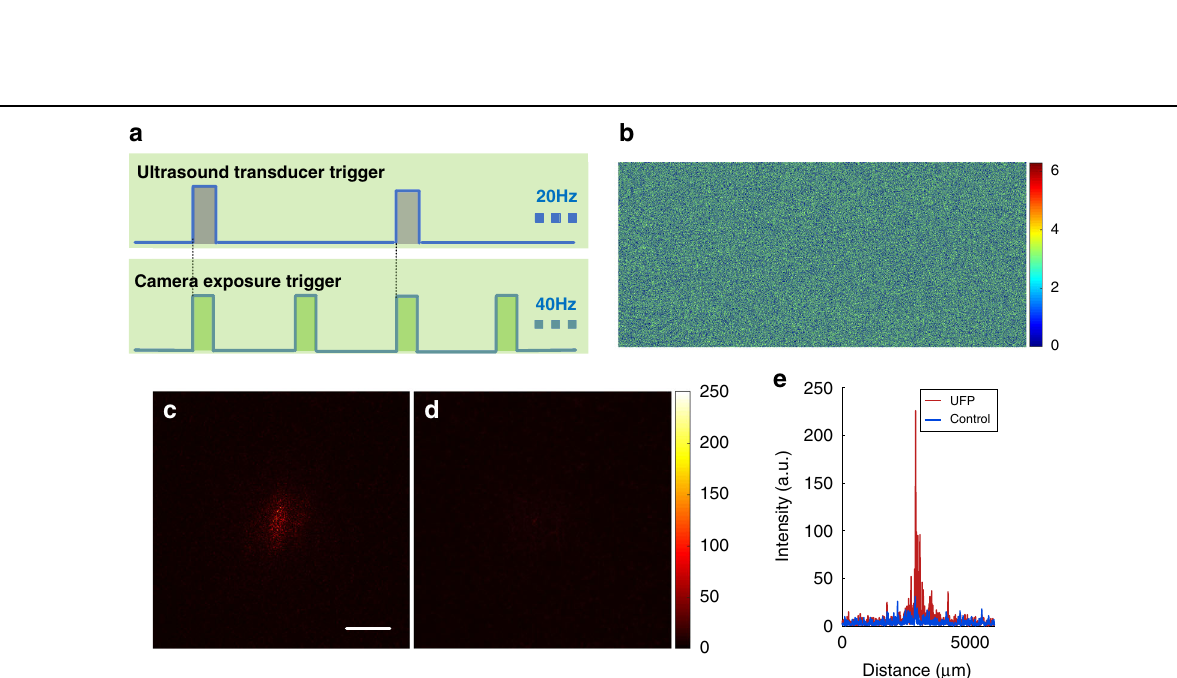
Fig. 5 Double-shot UFP optical focusing into scattering media. a Time sequence for double-shot UFP optical focusing. b Phase map generated from the two recorded hologram frames. c Time-reversed focus from double-shot UFP optical focusing. d In a control experiment, no focus was observed on the observation camera in a double-shot measurement without ultrasound. e Line pro fi les of the central rows in c and d . Scale bar: 1